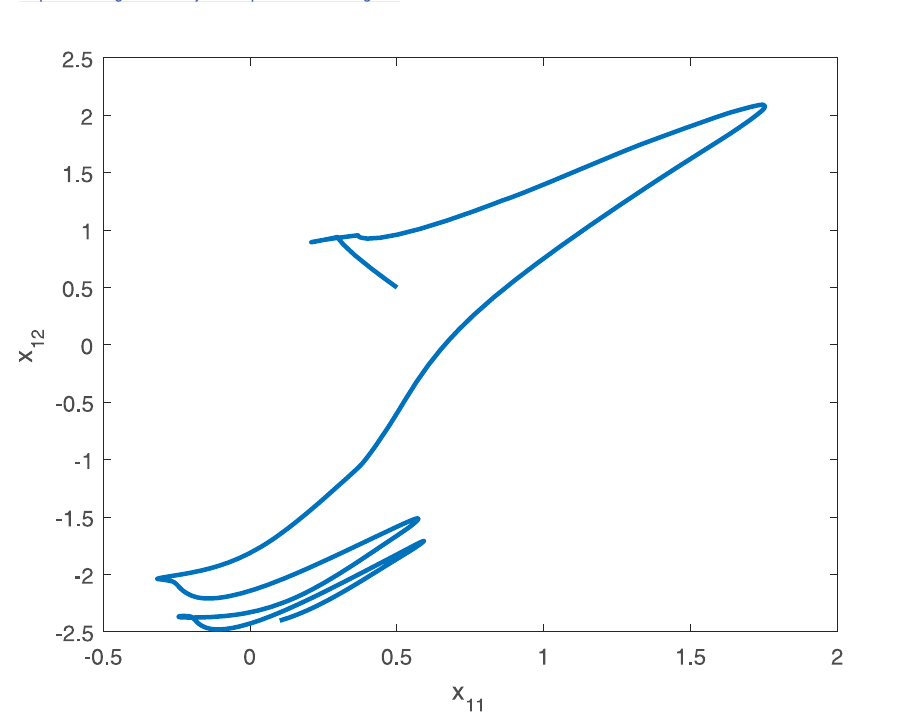
Fig 3. The phase diagram of the first neuron( x 11 − x 12 ) of the drive system (18) with initial conditions x 1 ( t 0 ) = [0.5 + sin ( t ), cos ( t )− 0.5] T , x 2 ( t 0 ) = [ sin ( t )− 0.5, 0.5 + cos ( t )] T , x 3 ( t 0 ) = [ sin ( t ), cos ( t )] T when no controller (8).